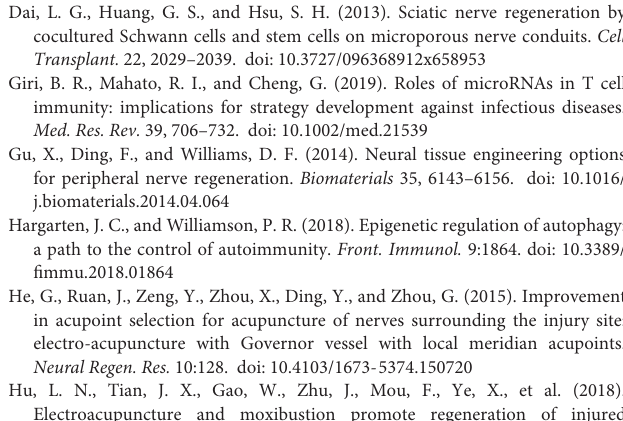
Supplementary Figure 1 | Overexpression of miR-1b inhibited the proliferation and migration of SCs and promoted cell apoptosis. (A) The cell viability was examined by CCK-8 assay. ∗∗ P < 0.01 versus the MC group. (B) The cell migration was detected by Transwell migration assay. Scale bar = 25 µ m. ∗∗ P < 0.01 versus the MC group. (C) TUNEL staining was used to detect cell apoptosis. Scale bar = 50 µ m. ∗∗ P < 0.01 versus the MC group. Supplementary Figure 2 | EA promoted myelin and axon regeneration through down-regulating miR-1b. (A) General observation of nerve cross-sectional structure by Masson trichrome staining. The nerve membrane which was rich in collagen fibers was stained blue, and the cytoplasm was stained red. Scale bar = 25 µ m. (B) Detection of myelin regeneration by immunohistochemical staining of myelin basic protein (MBP). Scale bar = 25 µ m. (C) Detection of axon regeneration by immunofluorescence staining of Neurofilament Heavy (NF200). Scale bar = 25 µ m. Supplementary Figure 3 | Rat drug administration timeline, modeling photos and general observation. (A) Timeline for the experimental design. (B) Modeling photos: (1) The sciatic nerve was dissociated. (2) The sciatic nerve was cut off. (3) The silicone tube was connected to the nerve ends. (4) The outer nerve membrane was sutured with silk thread. (5) The skin was sutured. (6) EA treatment. (C) Observation of the general condition of the affected foot of